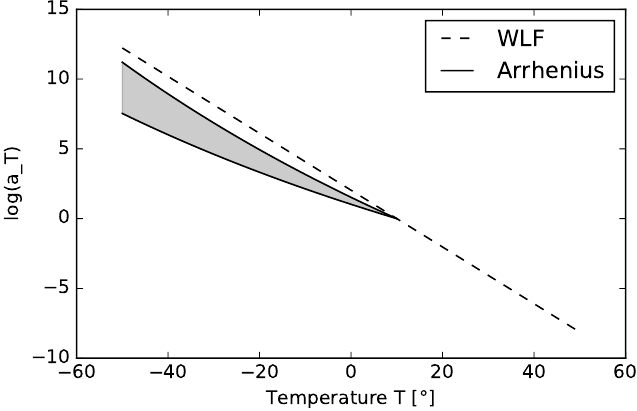
Figure 3. Comparison of PVB shift factors defined by the WLF equation and Arrhenius equations [26] for T g = 10 ◦